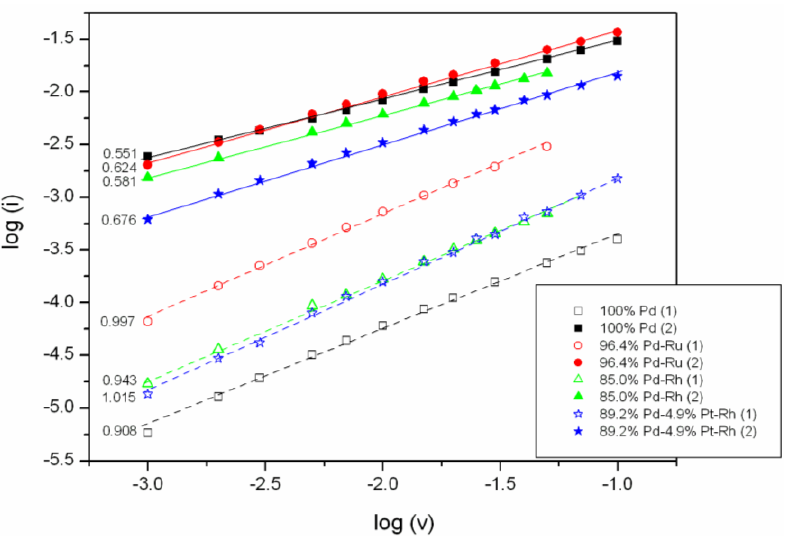
Figure 2. Influence of scan rate on anodic peak currents of signals 1 and 2 recorded during voltammetric oxidation of electrosorbed hydrogen in Pd and Pd alloys (in double-logarithmic coordinates, slopes indicated at the left). Temperature 298